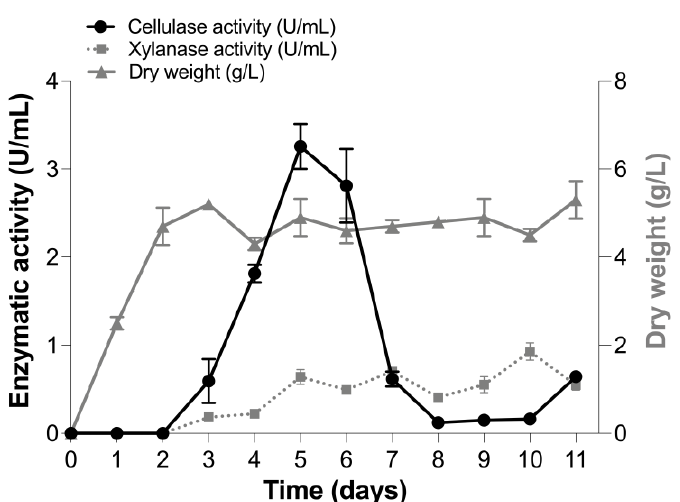
Figure 1. Cellulase and xylanase activity and dry weight of T. terrestris Co3Bag1 at 45 C. Cellulase activity (black circle), xylanase activity (gray square), and dry weight (gray triangle) were produced on a Zouari-Mechichi medium with 1% ( w / v ) CMC as a carbon source.